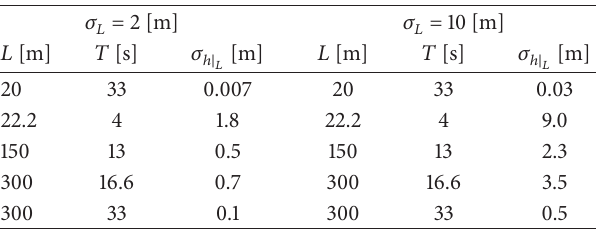
Table 1: Uncertainty in the estimated water depth due to that in , for different ( 𝐿,𝑇 ) and 𝜎 𝐿 values. swell wavelength, 𝜎 ℎ| 𝐿